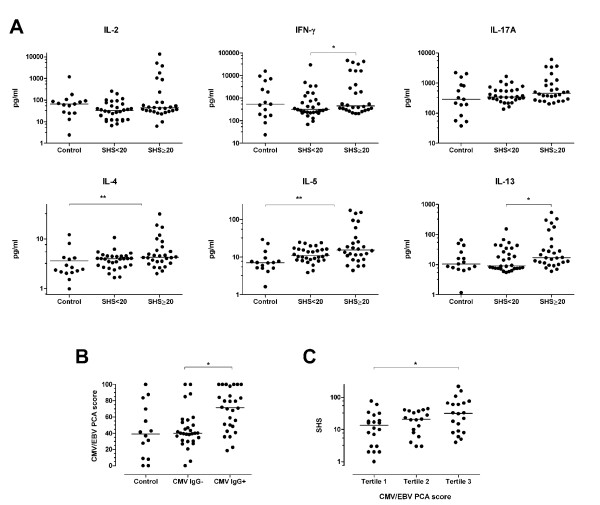
A profile of immune response mainly to CMV correlates with radiographic joint damage in RA. (A) Shown are normalized cytokine concentrations released from peripheral blood mononuclear cells into culture supernatants following 48 hours of stimulation with combined CMV/EBV lysates among healthy blood donors (Control), patients with 'low' joint damage (SHS < 20), and patients with 'high' joint damage (SHS > 20). Cytokines were selected based on the results of the principal components analysis (PCA) with factor loadings > 0.5 for the first factor. All data are adjusted for age and sex using mixed effects models. Statistical significance was tested using 2 degree of freedom tests in the mixed effects models. *P < 0.05. **P < 0.01. (B) Shown are the distributions of the CMV/EBV PCA score for the first principal component among healthy blood donors (Control), patients with negative CMV IgG (CMV IgG-), and patients with positive CMV IgG (CMV IgG+). *P < 0.05 for the Kruskal-Wallis test. (C) Shown are the distributions of radiographic joint damage defined by the total Sharp-van der Heijde score according to the tertiles of the CMV/EBV-1 PCA score. *P < 0.05 for the univariate Spearman correlation coefficient. In all panels, the horizontal lines are the medians. CMV, cytomegalovirus; EBV, Epstein-Barr virus; IFN-γ, interferon gamma; IgG, immunoglobulin G; IL, interleukin; PCA, principal components analysis; pg/ml, picograms per milliliter; RA, rheumatoid arthritis; SHS, Sharp-van der Heijde total score